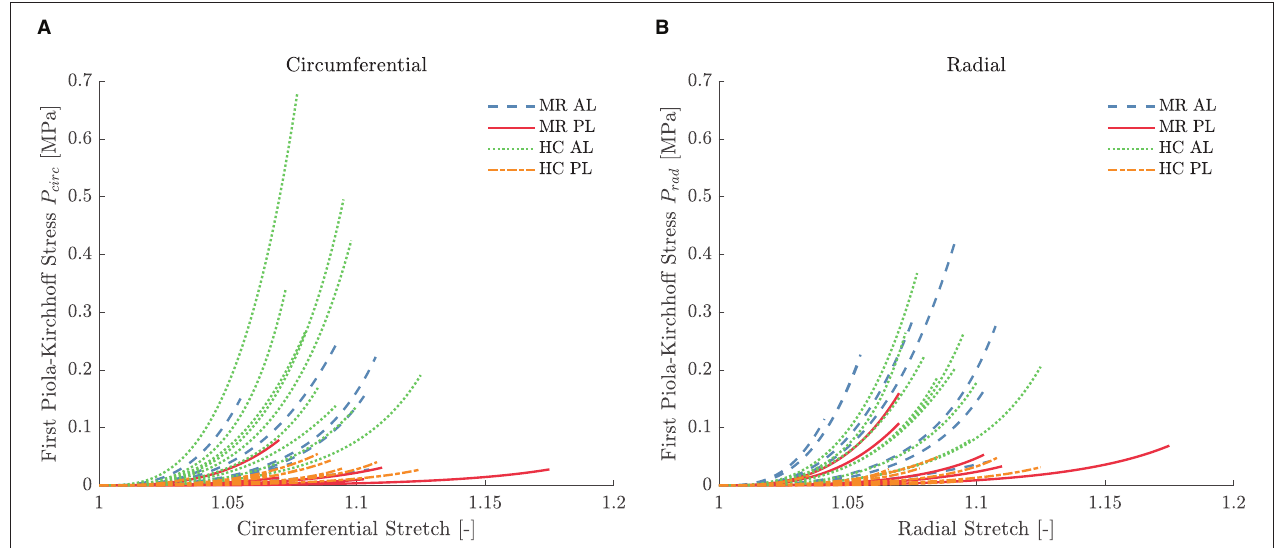
FIGURE 6 | Equibiaxial first Piola-Kirchhoff stress versus stretch in the (A) circumferential and (B) radial direction of the different leaflet samples. The model stress was derived by parameter fitting to the MN constitutive model. The stretch range was defined based on the experimental data of the highest reached strain level for each sample.